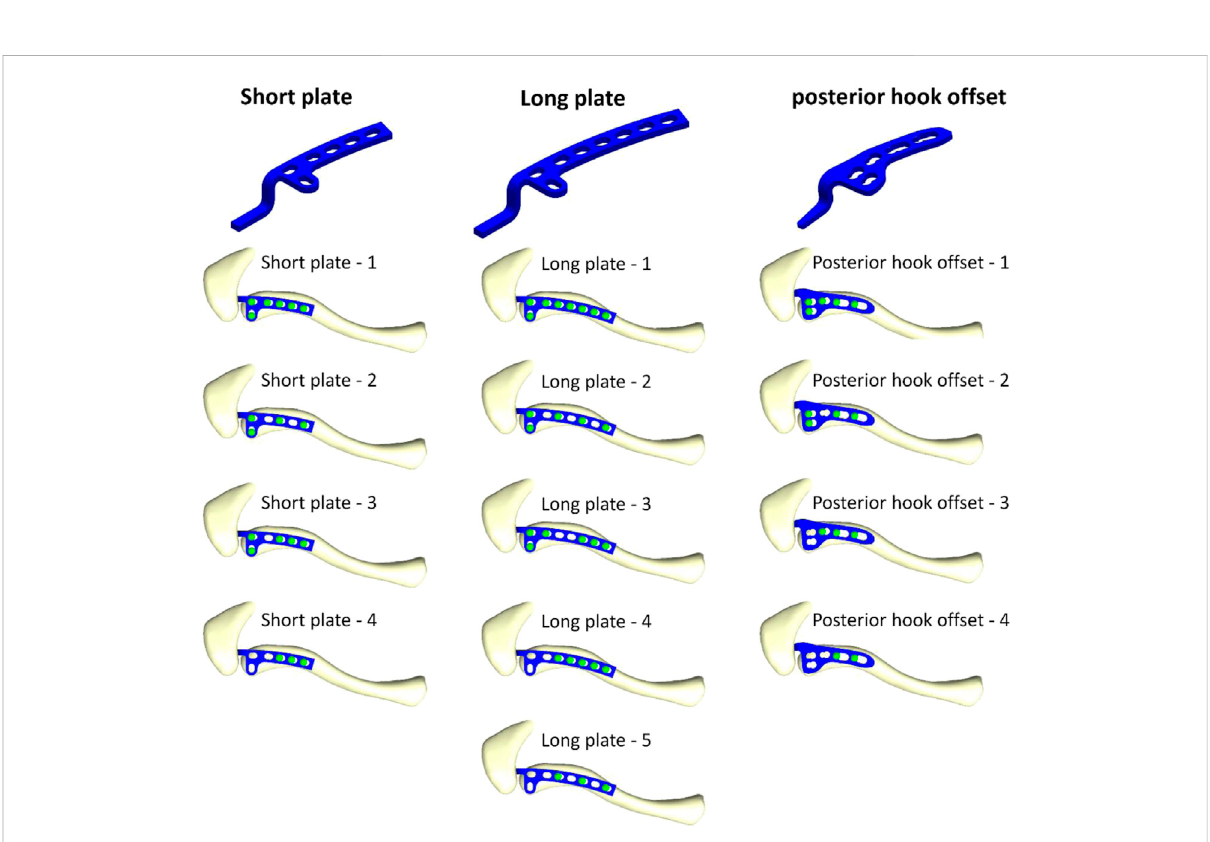
FIGURE 2 Thirteen models composed of three different clavicle hook plates, with various screw placement